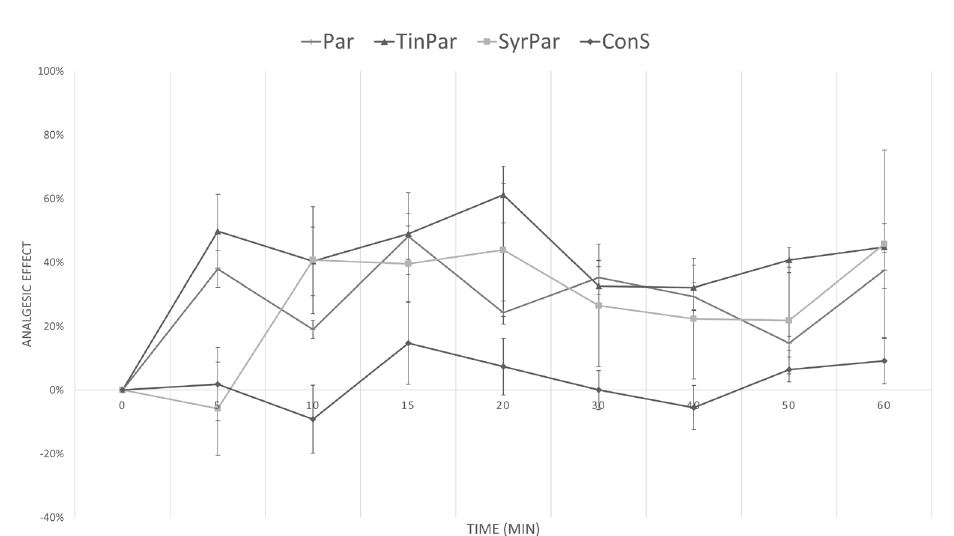
FIGURE 2 - Interactions between different Thyme formulations and paracetamol. Analgesic effect is expressed as a percentage of prolongation of measured reaction time compared to control reaction time (Abbreviations - ConS: control group, Tin: thyme tincture, Syr: thyme syrup, Par: paracetamol, TinPar: thyme tincture and paracetamol, SyrPar: thyme syrup and paracetamol).